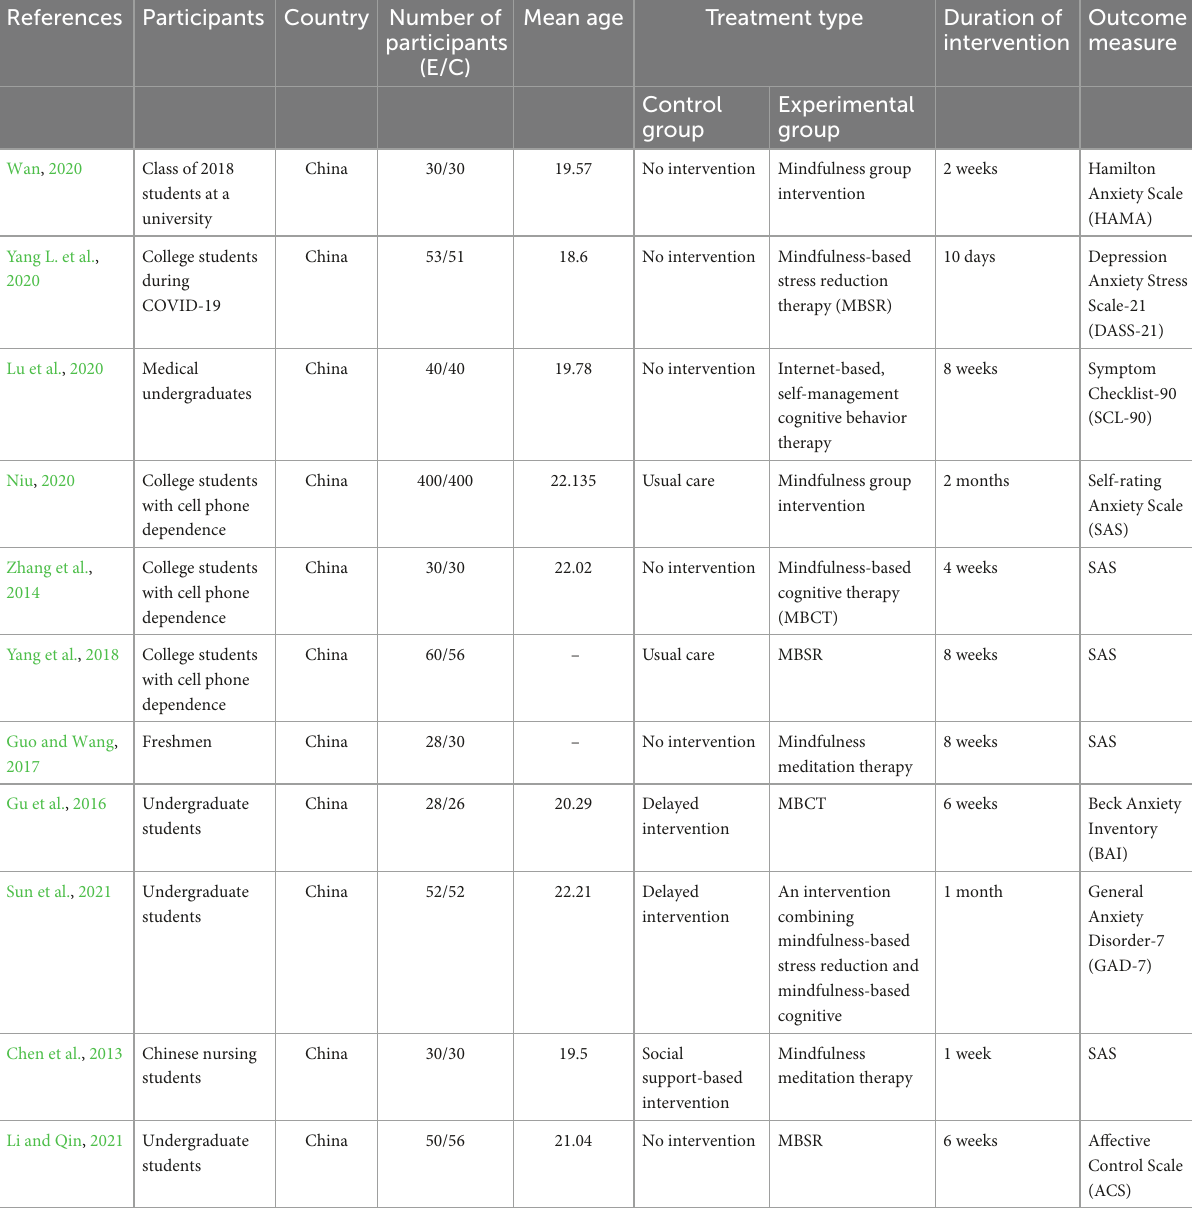
TABLE 2 Basic characteristics of the included